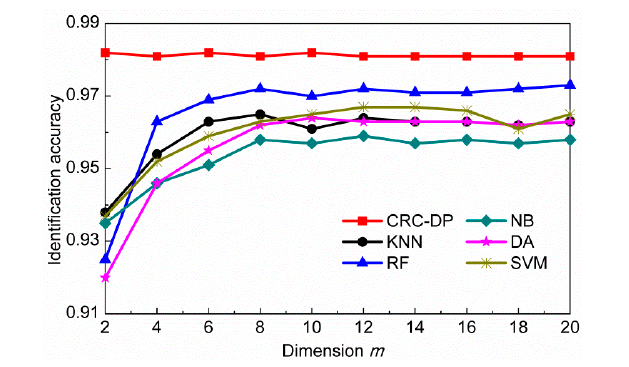
Figure 6. The identification accuracy versus the reduced sample dimension m . Table 2. Mean online identification time of each query sample for three-class classification.